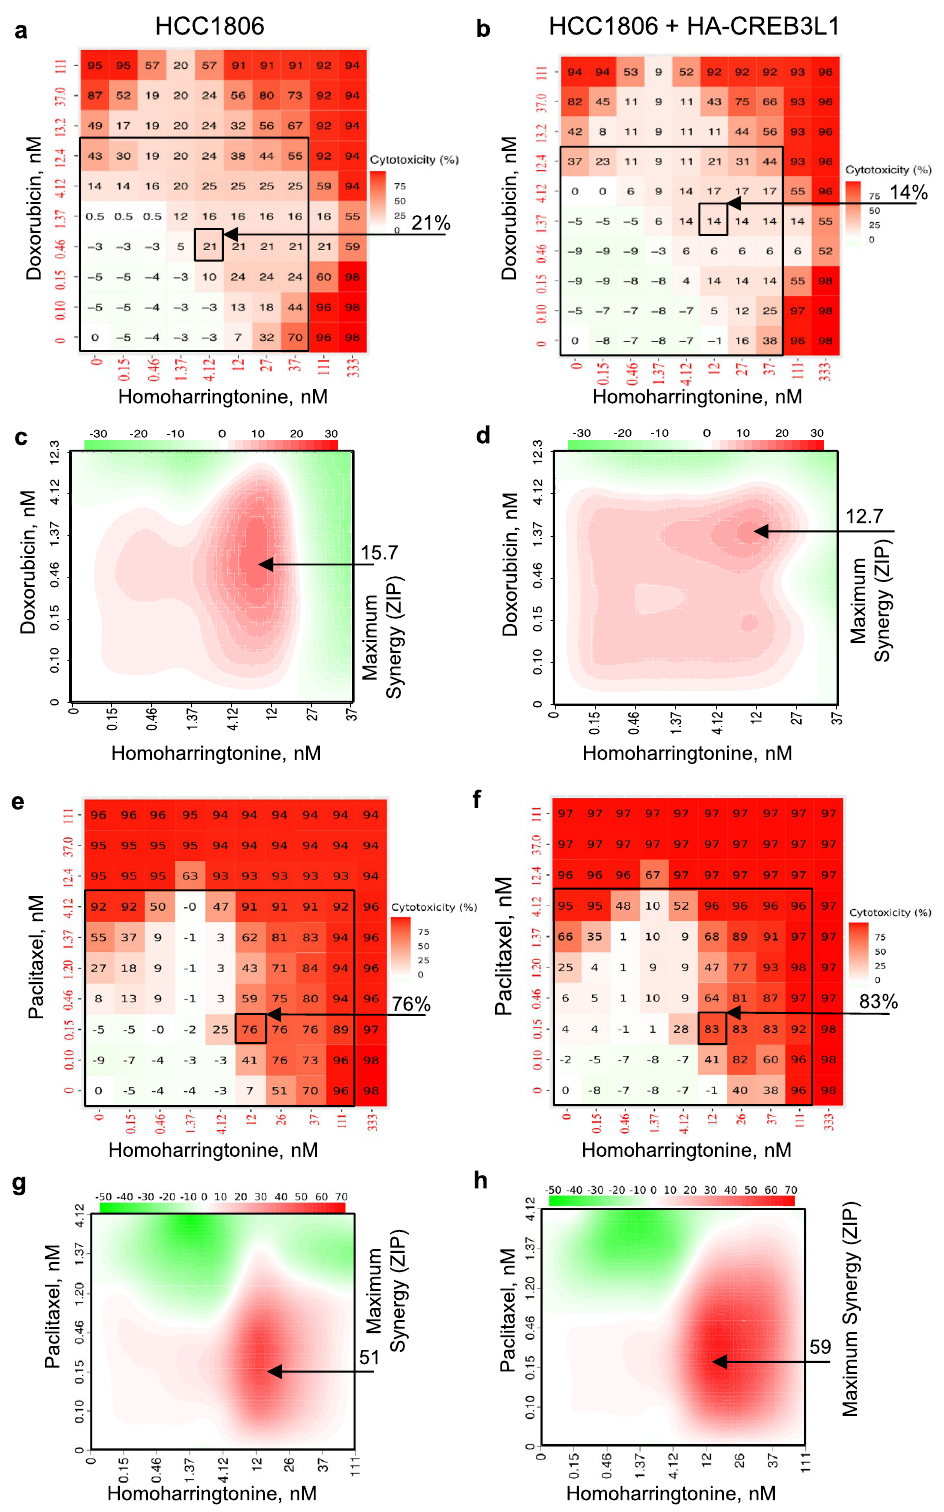
Figure 7. Assessing possible drug synergy between homoharringtonine and either doxorubicin ( a-d ) or paclitaxel ( e–h ). Cell viability ( a, b, e, f ) was measured after 4 days of drug treatment over a range of drug concentrations for HCC1806 ( a, c, e, g ) and HCC1806 + HA-CREB3L1 ( b, d, f, h ) cells. Homoharringtonine EC 50 for HCC1806 = 29 nM; 1:3 serial dilutions (0–333 nM). Doxorubicin EC 50 for HCC1806 = 13 nM; 1:3 serial dilutions (0–111 nM). Paclitaxel EC 50 for HCC1806 = 1.2 nM; 1:3 serial dilutions (0–111 nM). A zero- interaction potency score (ZIP; c, d, g, h ) was calculated by the SynergyFinder R-package for each data point to measure possible drug synergy; ZIP > 10 indicates